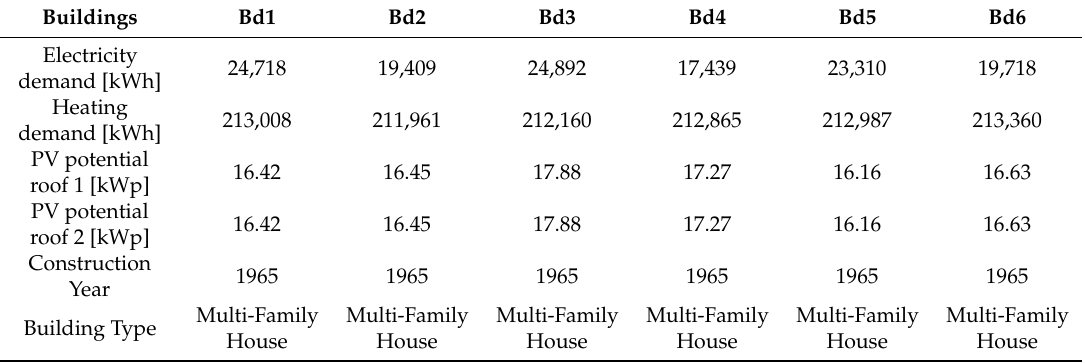
Table A1. Yearly electricity and heat demand and PV potential per